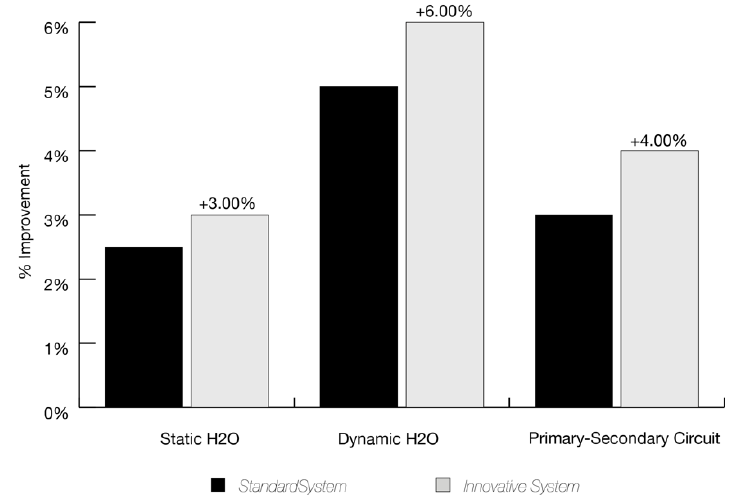
Figure 11. Thermal exchange increasing comparison between standard and innovative geo-heat exchange prototype for static, dynamic and primary/secondary tests.